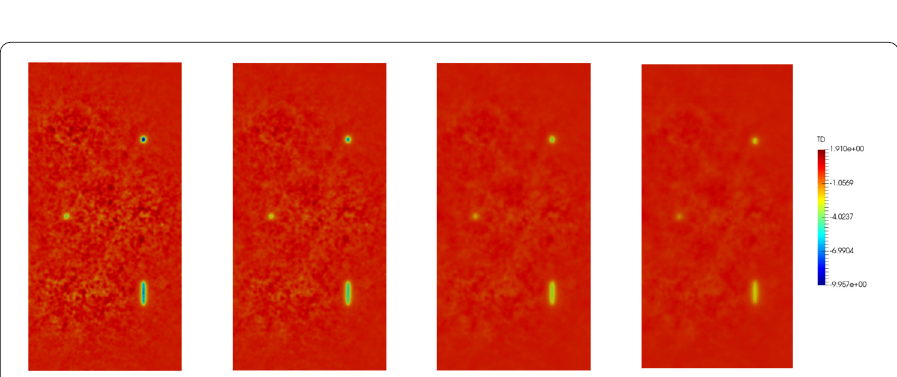
Figure 15 Values of the topological derivative on several planes of the form x = x 0 . First: x = – (cid:2) x /2. Second: x = – (cid:2) x /4. Third: x = 0. Forth: x = (cid:2) x